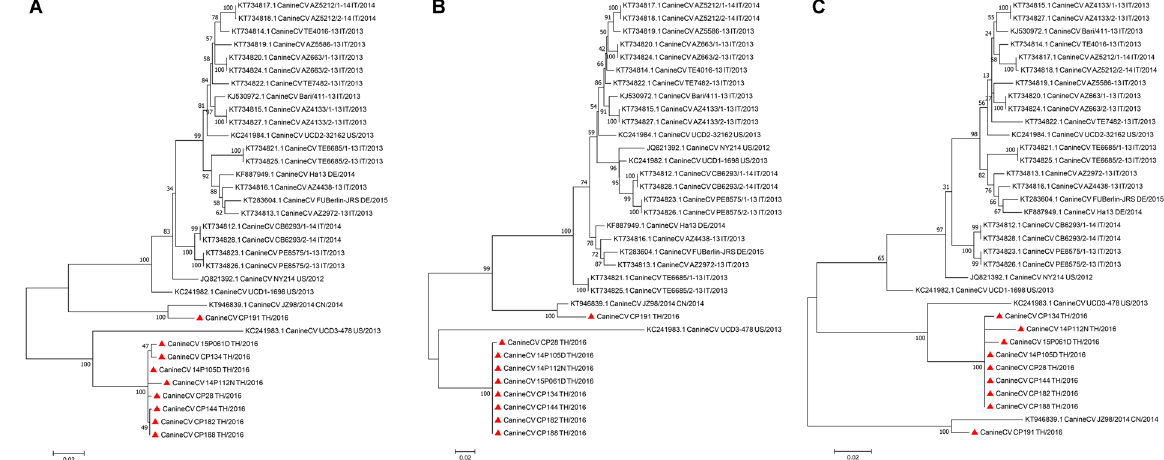
Figure 2. Phylogenetic tree of CanineCVs shows that strains detected in Thailand (red triangles) were mostly clustered with CanineCV UCD3-478; however, the CanineCV CP191 TH/2016 was clustered with CanineCV JZ98/2014 ( A ). The phylogenetic tree of individual Rep ( B ) and Cap genes ( C ) of CanineCV genomes were also constructed and suggested the CanineCV circulating in Thailand were divergent and revealed discrepant patterns among genes by showing distinct and divergent homologous clade of Rep gene, compared to Cap